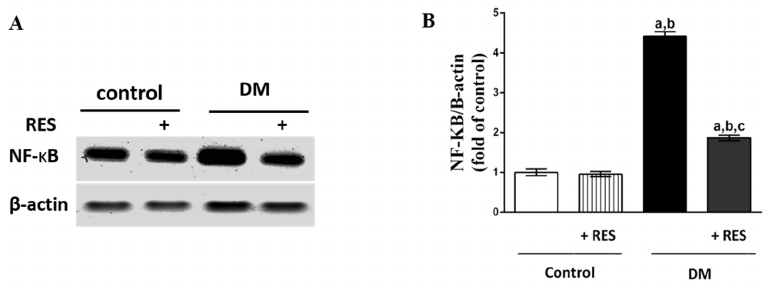
Figure 5. ( A , B ) Expression of NF- κΒ in β cells was significantly increased in STZ-injected animals in comparison with normal mice. RES treatment significantly reduced the expression level of NF- κΒ of STZ-treated group in comparison with the STZ-injected group. No change was found in NF- κΒ expression in RES-injected mice in comparison with the normal group. Data represent mean ± SEM: a difference is significant compared to control group; b difference is significant compared to RES group; c difference is significant compared to diabetic group at p < 0.05.